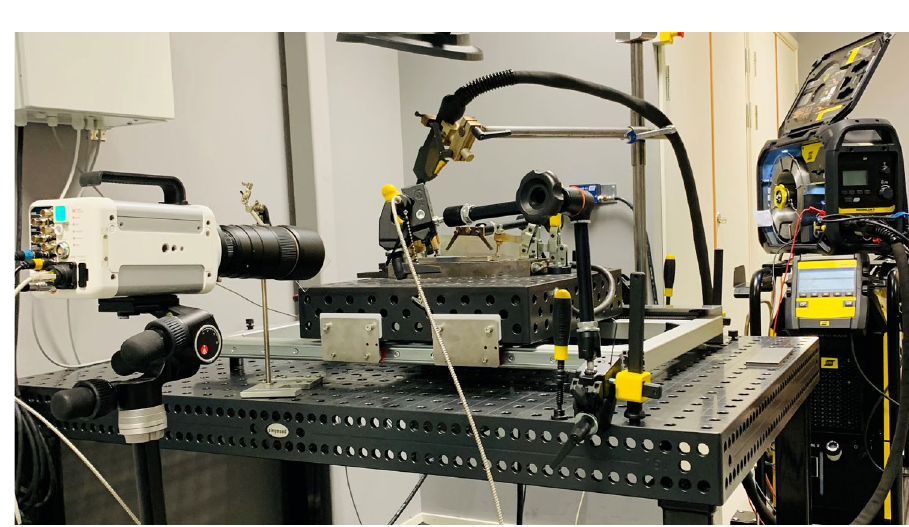
Fig. 2 Image and data process- ing